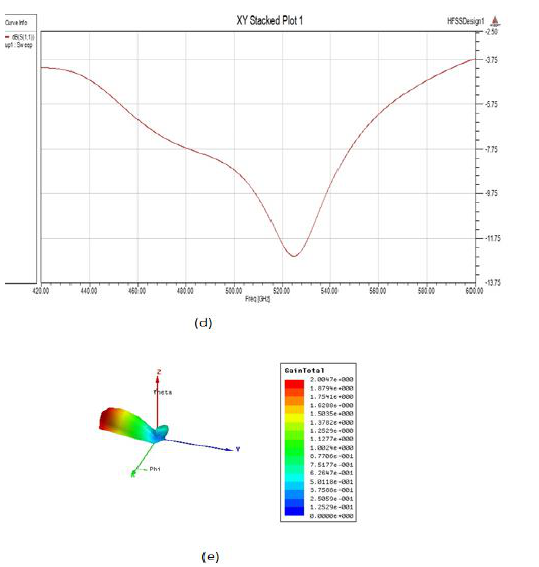
Figure 9: (d) S11 plot of radiation at 524.8 GHz, bandwidth 25 GHz, (e) Gain of Antenna